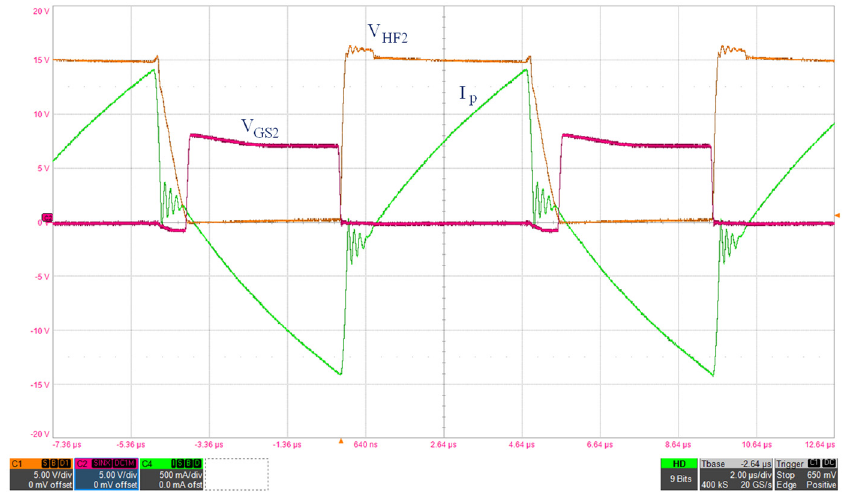
Figure 20. Switching Waveforms at high load (I load = 1 A). V GS2 = 5 V/div, V HF2 = V DS2 = 5 V/div, I p = 1 A/div, t = 2 μ s/div.